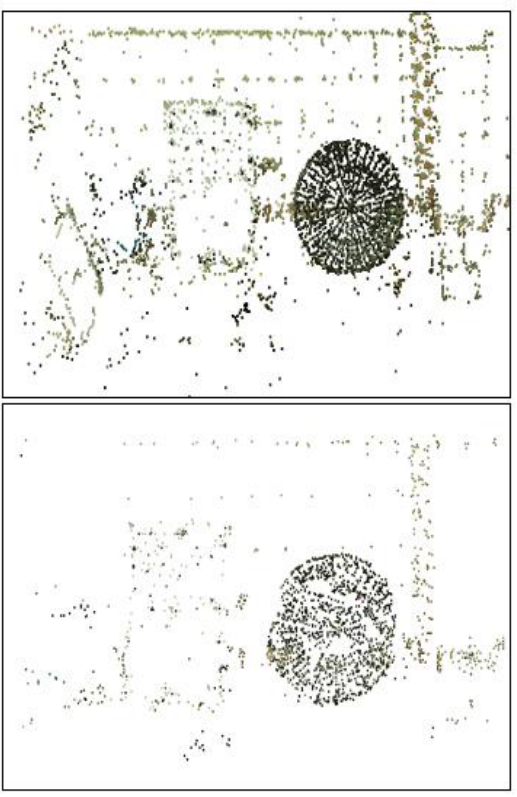
Figure 4. before (top) and after (bottom) preprocessing the corresponding tie points Check points are used to assess the developed strategy. Four